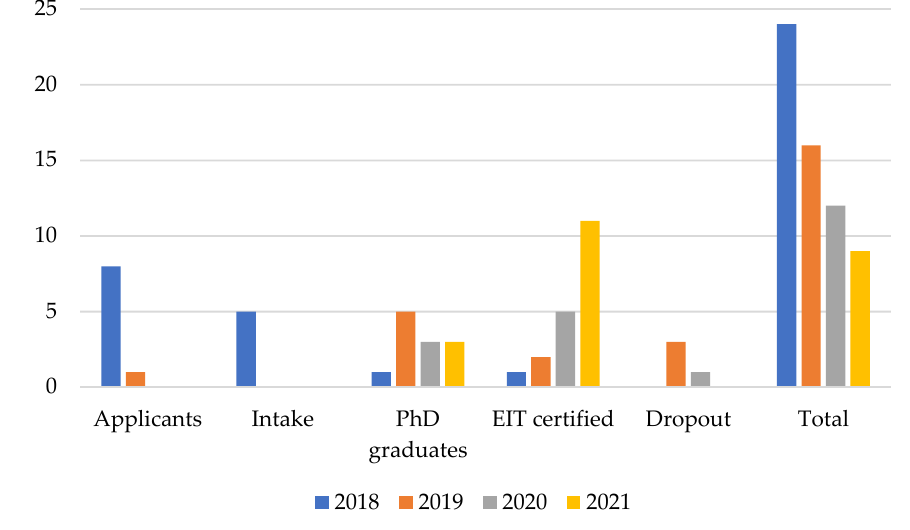
Figure 6. Programme participants from 2018–2021.